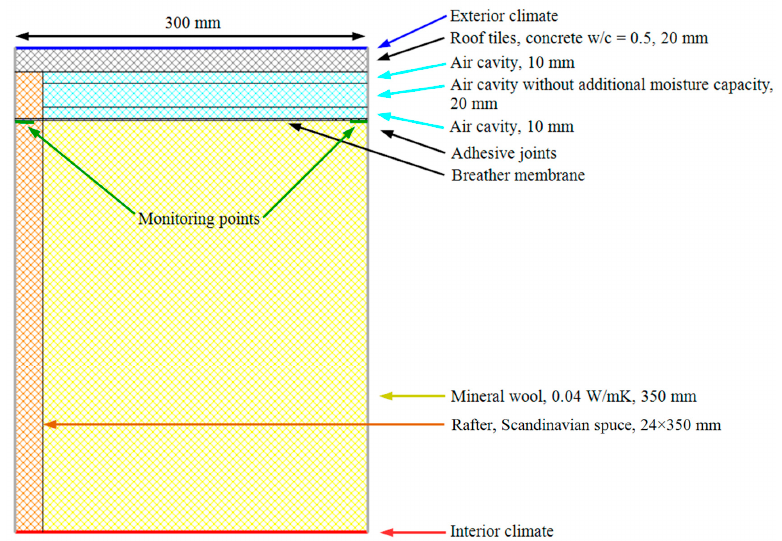
Figure 4. Roof geometry simulated in WUFI